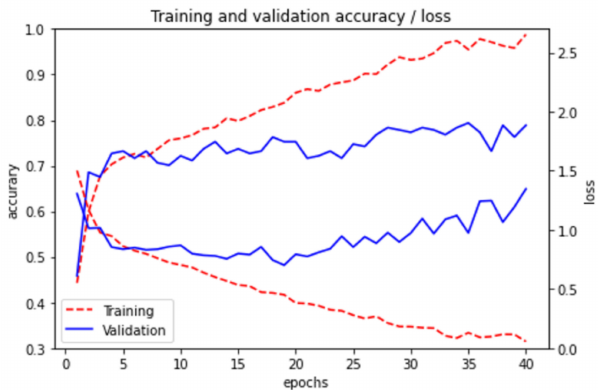
Figure 6. Accuracy and Loss for CNN model for training and validation set.